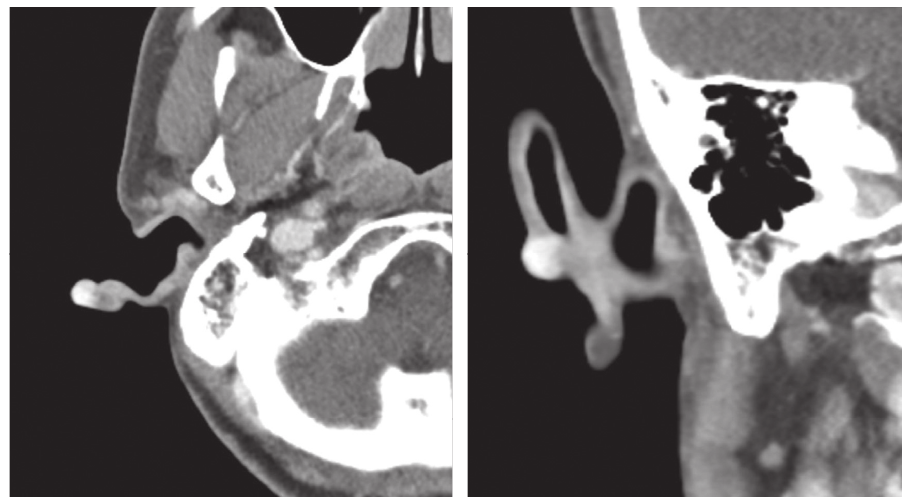
Figure 2: Facial computed tomography revealing a 0.8 × 0.6 cm strongly enhanced mass in the right auricle. (a) Axial image; (b) coronal